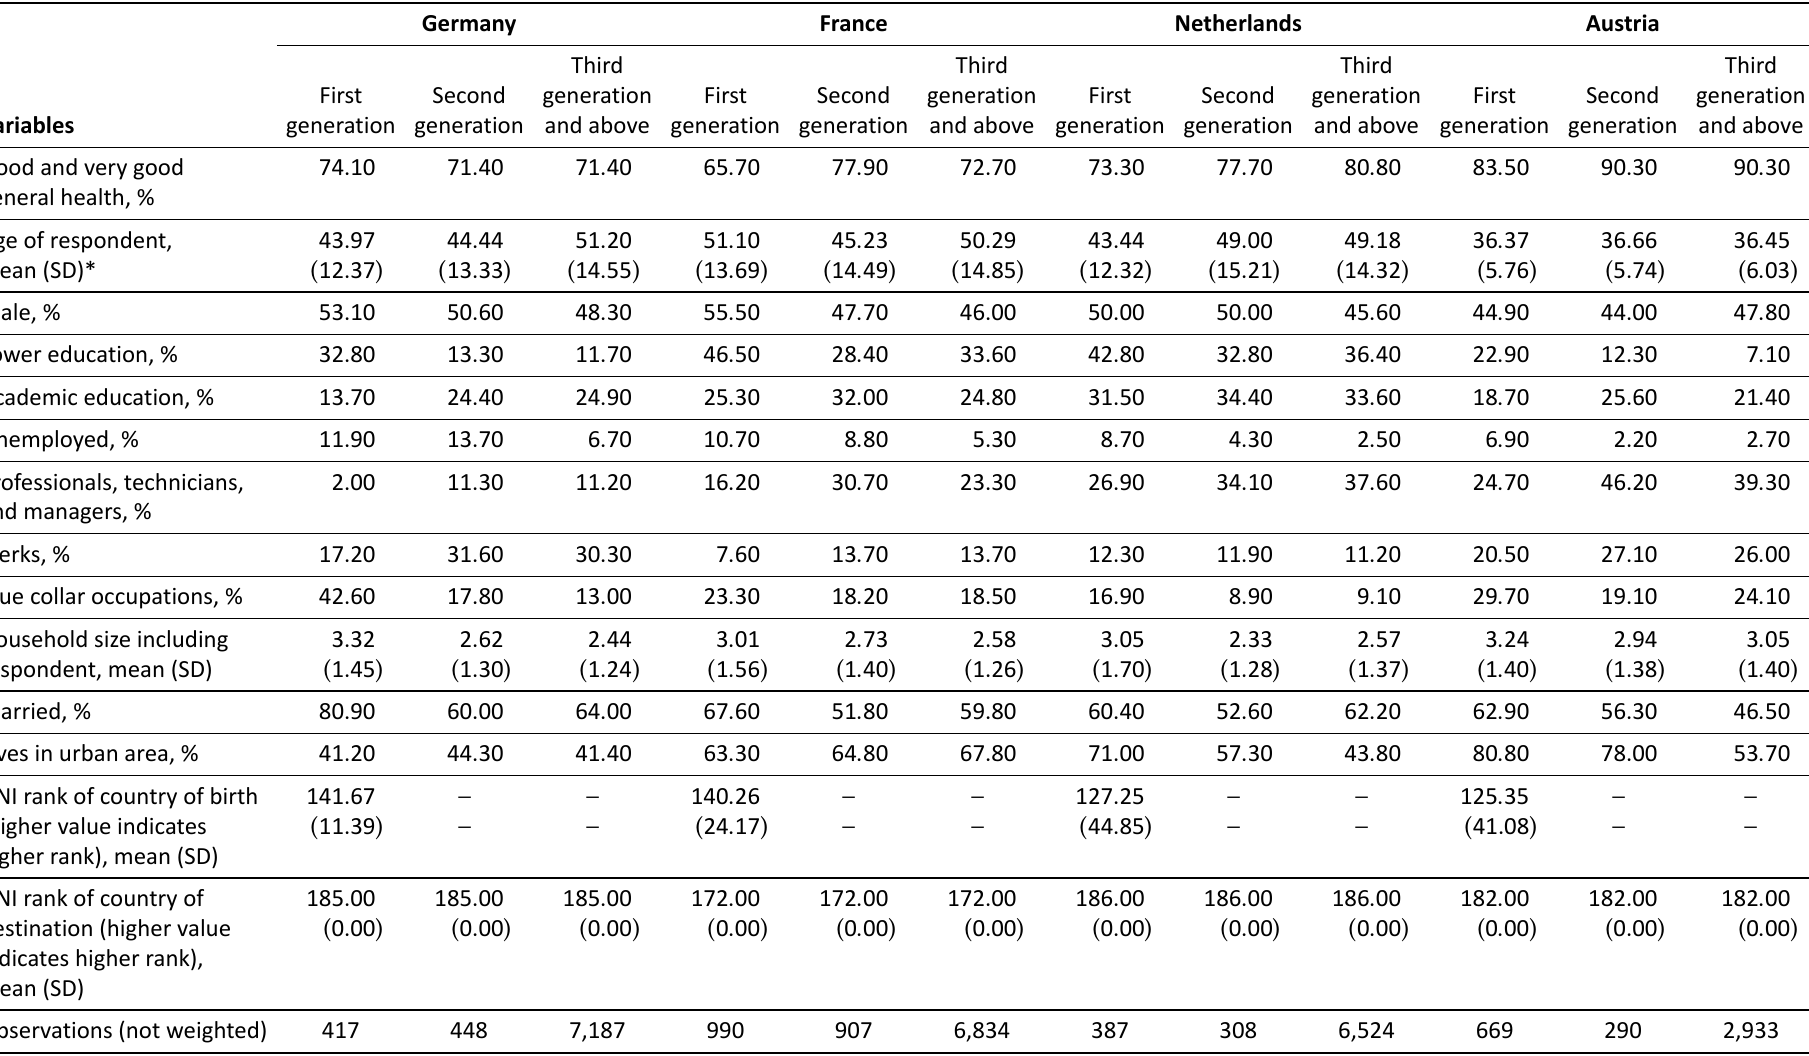
Table 1. Descriptive statistics by country of destination and generation, 26 years of age and older. Germany France Netherlands